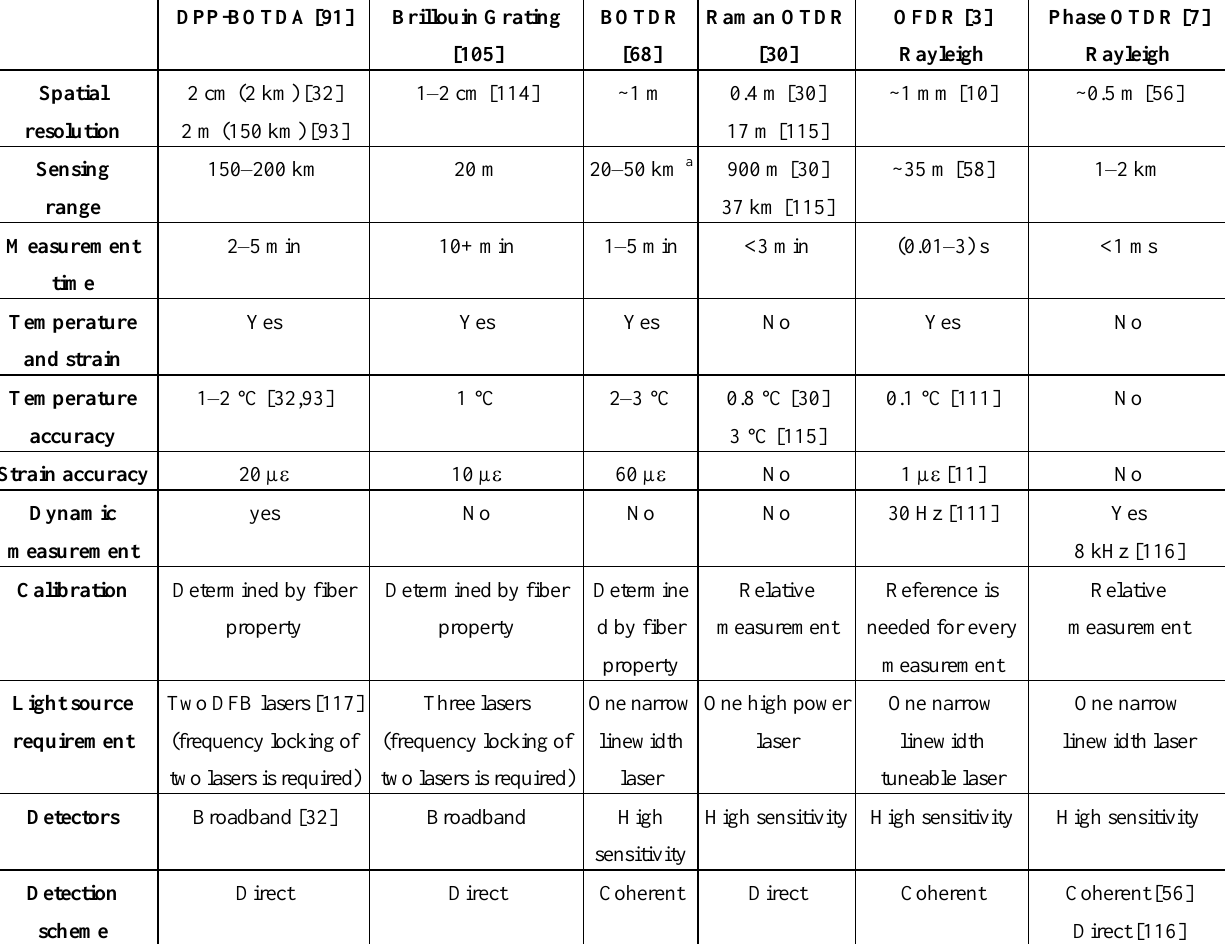
Table 2. Performance chart for distributed